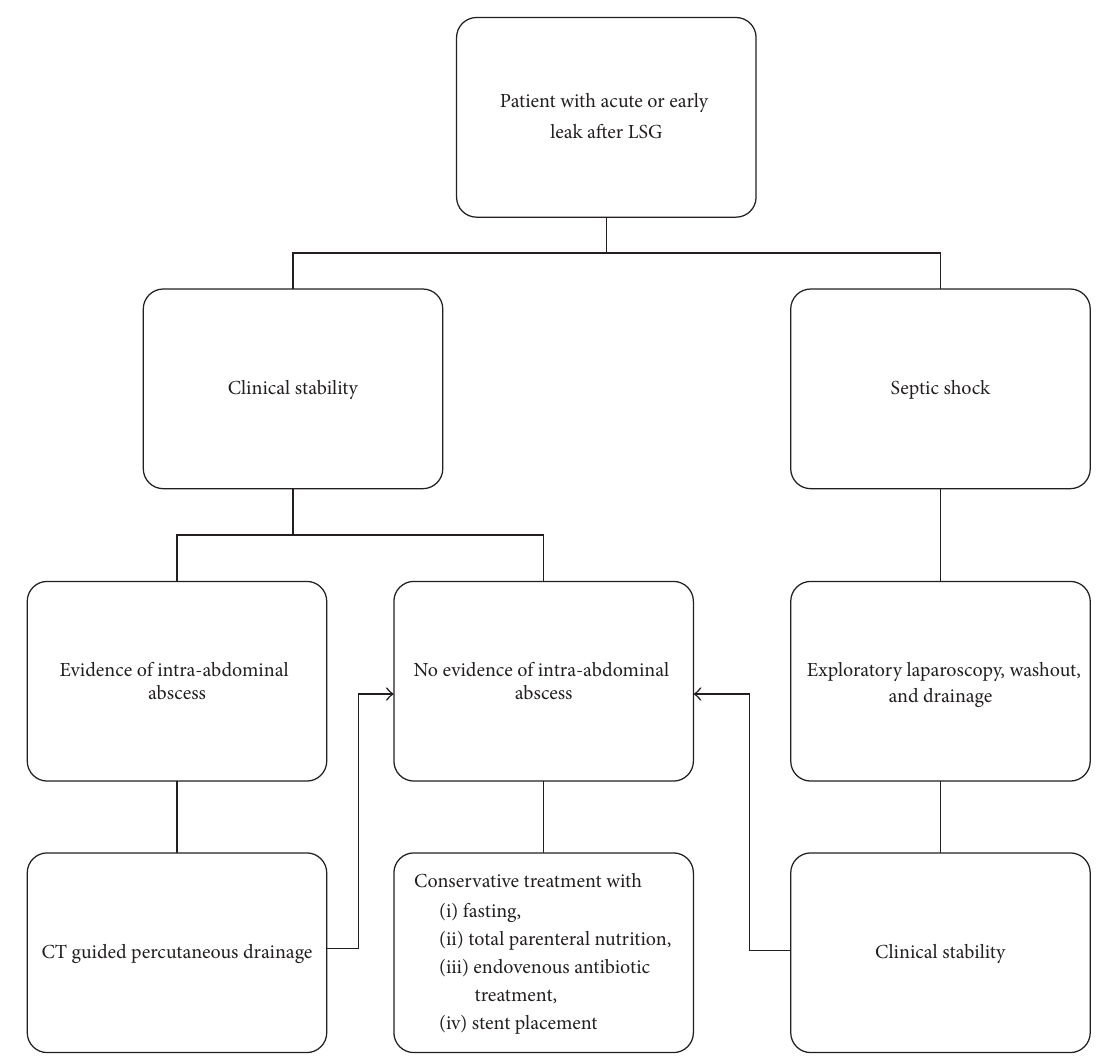
Figure 3: Flow chart for the management of gastric